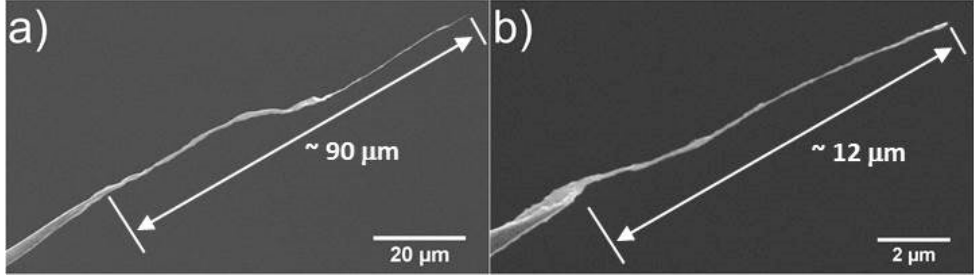
Figure 3. Scanning electronic microscopy (SEM) images showing the variation in fibre length with increased tip-sample separation from ( a ) 100 µm to ( b ) 400 µm.